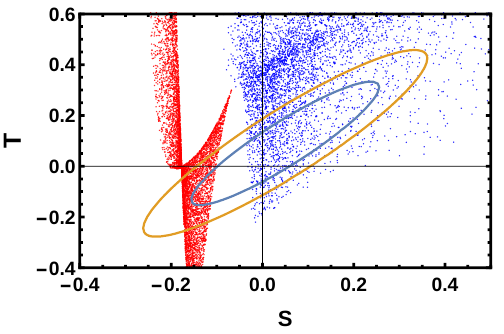
Figure 4 . Scatter plot of S and T values in (cid:23) 2HDM (red points) and in (cid:23) 2HDM + Vectorlike leptons (cid:31); (blue points). m H = 0 : 1 eV, m = m (cid:31) = 150{250 GeV, y (cid:31) = 1. Experimentally allowed 1 (cid:27) and 2 (cid:27) contours of S, T values are also